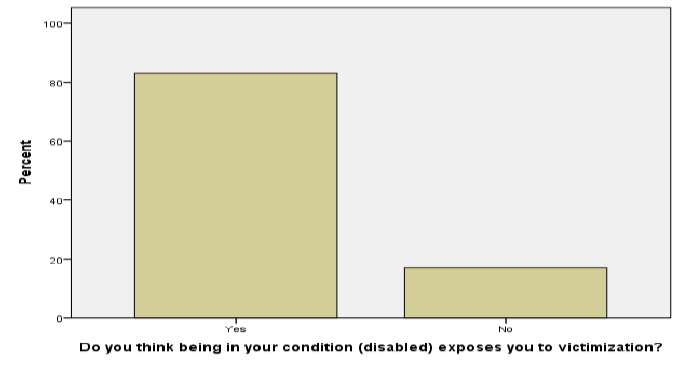
Figure 4: Exposure to Victimization Due to Disability